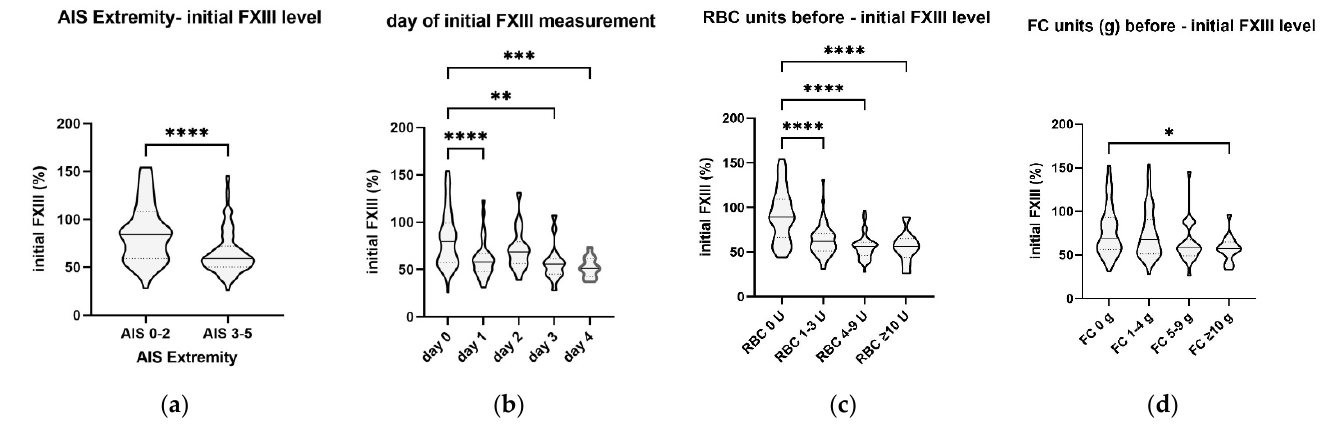
Figure 3. Clustered determinants on the initial FXIII level. ( a ): AIS, abbreviated injury score for the extremity region; ( b ): first measurement day post trauma, with 0 in the first 24 h, 1 between 24 and 48 h; 2 between 48 and 72 h, 3 between 72 and 96 h, 4 between 96 and 120 h; ( c ): RBC, red blood cell concentrate; ( d ): FC, fibrinogen concentrate; level of significance indicates * p < 0.05, ** p < 0.01, *** p < 0.001 and **** p < 0.0001; all other comparisons are not significant.